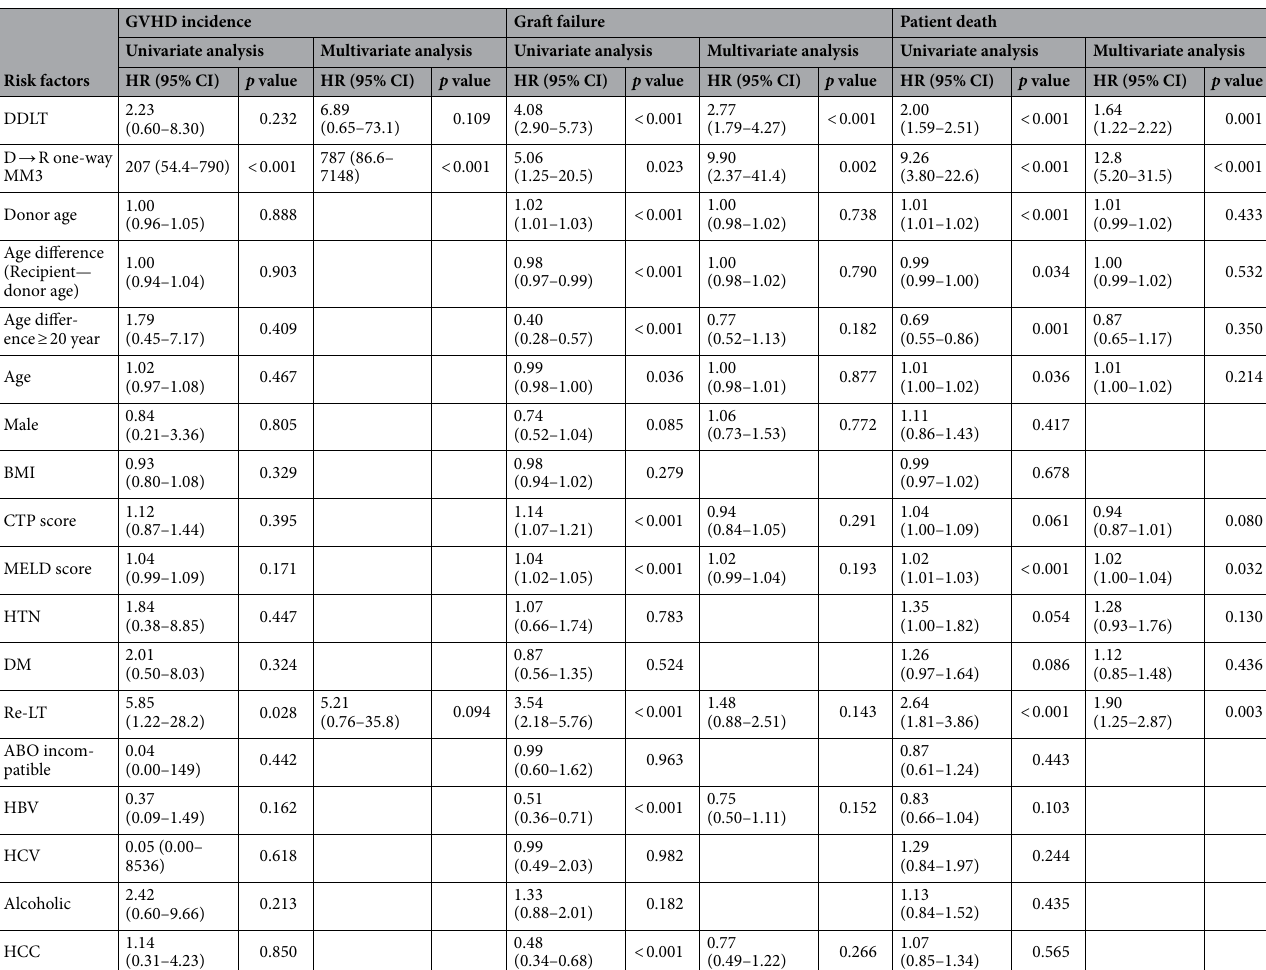
Table 4. Risk factors for GVHD, graft failure, and patient death. GVHD, graft-versus-host disease; DDLT, deceased donor liver transplantation; D → R one-way MM3, donor against recipient one-way mismatch at three loci; BMI, body mass index; CTP, Child-Turcotte-Pugh; MELD, model for end-stage liver disease; HTN, hypertension; DM, diabetes mellitus; Re-LT, re-liver transplantation; HBV, hepatitis B virus; HCV, hepatitis C virus; HCC, hepatocellular